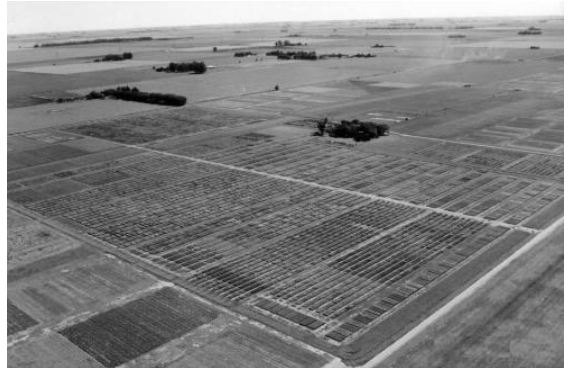
Figure 22. Argentinian Pampa region with wheat